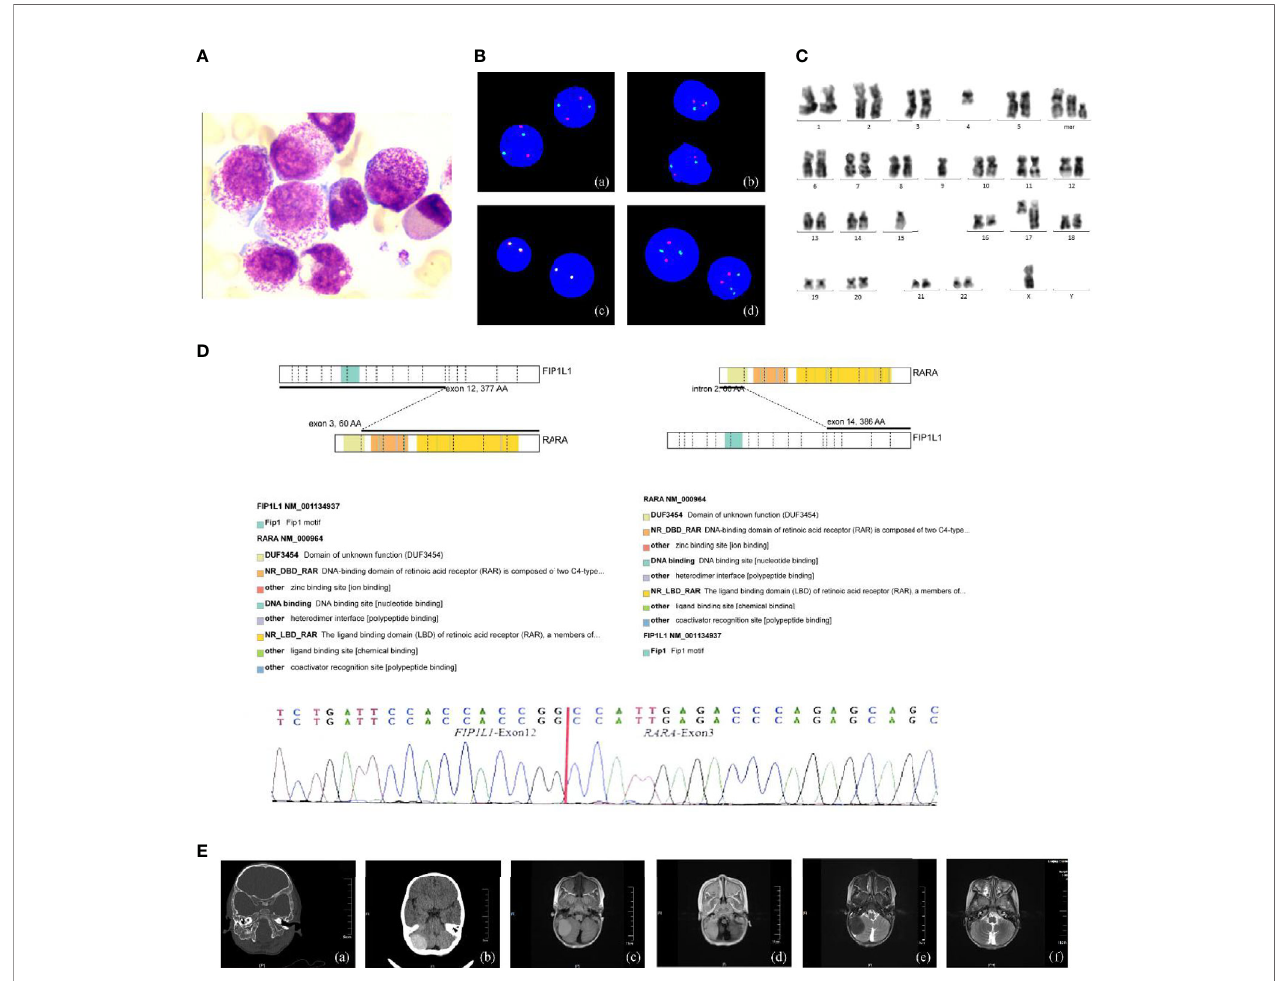
FIGURE 1 | The clinical information of the APL patient. (A) Bone marrow morphology at initial diagnosis. ×400; (B) FISH using the PML/RARA dual-color, dual- fusion translocation probe indicated the absence of the normal PML/RARA : (a) nuc ish(D5S23/D5S721,CSF1R)×2[400], (b) nuc ish (D7Z1/D7S486)×2[400], (c) nuc ish (MLL×2) [400], (d) nuc ish (PML×2, RARA×3)[292/400]; (C) G-banded karyotype of the patient; (D) Sequencing analysis of FIP1L1 – RARA fusion transcripts atonset. Diagrammatic representation and sequencing information of FIP1L1 – RARA fusion transcripts. FIP1L1 transcripts consisting of exon 12 joined to RARA intron 3 (variant form). (E) Intracranial tumor: (a, b) CT detects mass with some skull changes in the right posterior fossa, (c – e) MR image: in fi ltrative lesion involving the right posterior fossa, bilateral mandible, antrum maxillae, skull base, and partial vertebra, (f) complete resolution of the intracranial mass after the